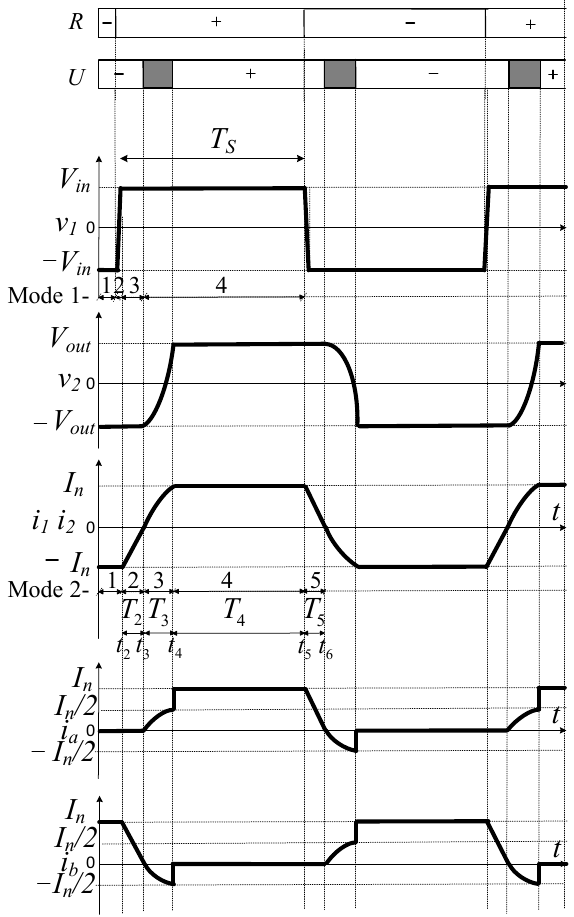
Figure 4. Operating waveforms of proposed SR-SAHB DC-DC converter.